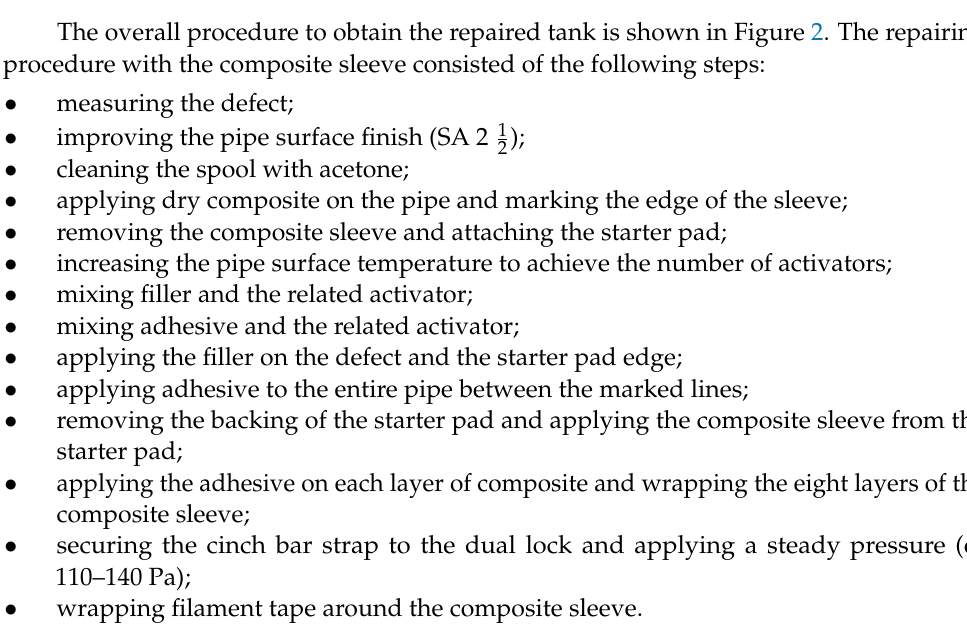
Figure 1. ( a , b ) CAD model showing size and shape of the machined defect; ( c ) CAD model of the whole pipe showing the defect positioning.